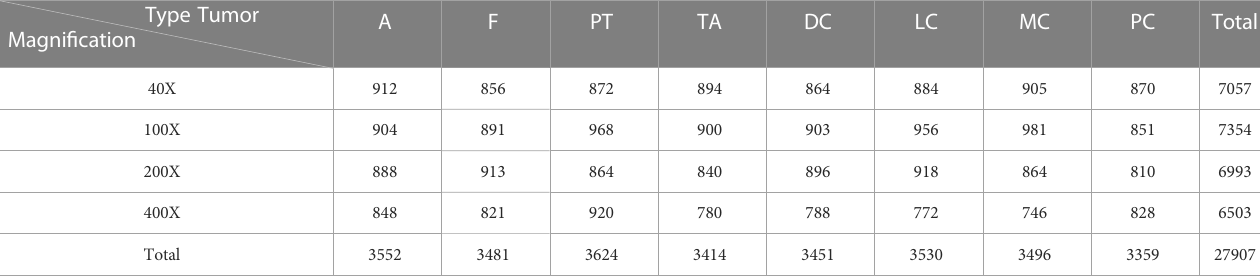
TABLE 3 The amounts of different types of data in BreaKHis dataset using data augmentation. Type Tumor